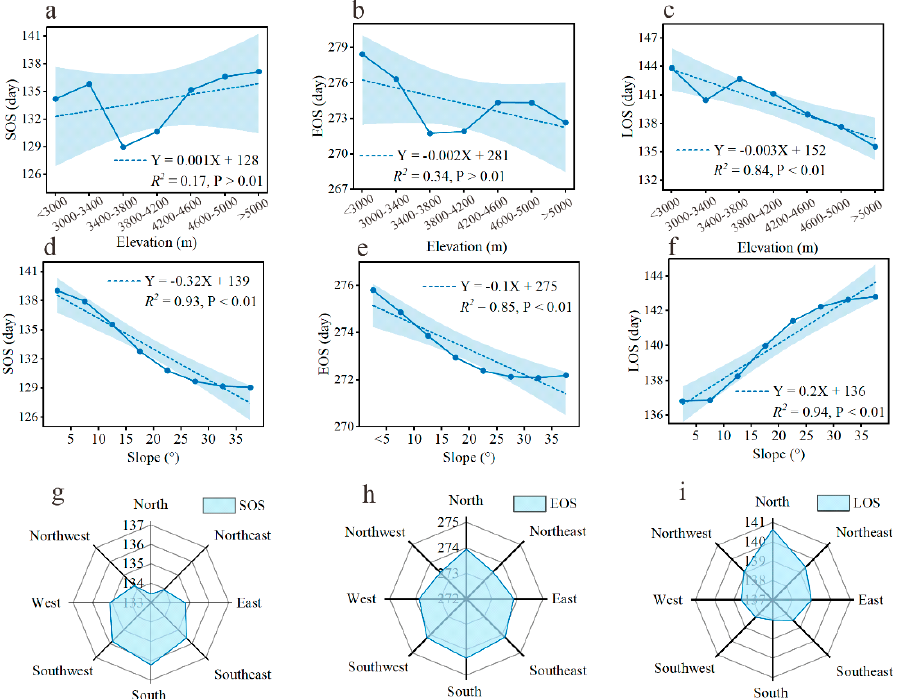
Figure 6. The relationship between different terrain factors and the start (SOS), end (EOS), and length (LOS) of the growing season: distribution and change characteristics at different elevations ( a – c ), slopes ( d – f ), and aspects ( g – i ).